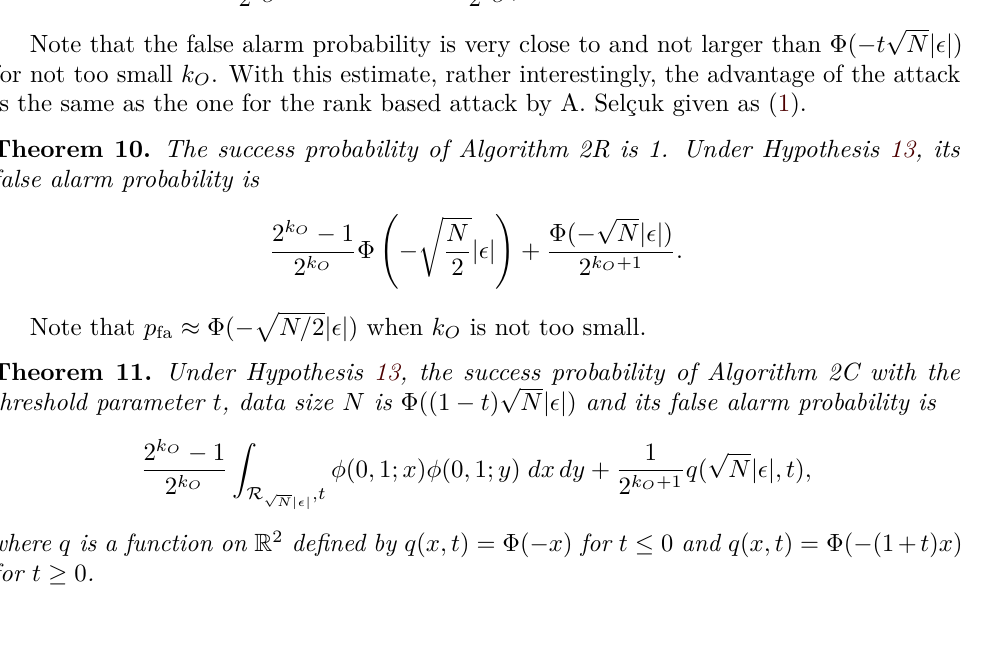
Algorithm 2R. After getting the list [ T ( κ, β, D ) , ( κ, β )], sort the list of ( κ, β )’s according